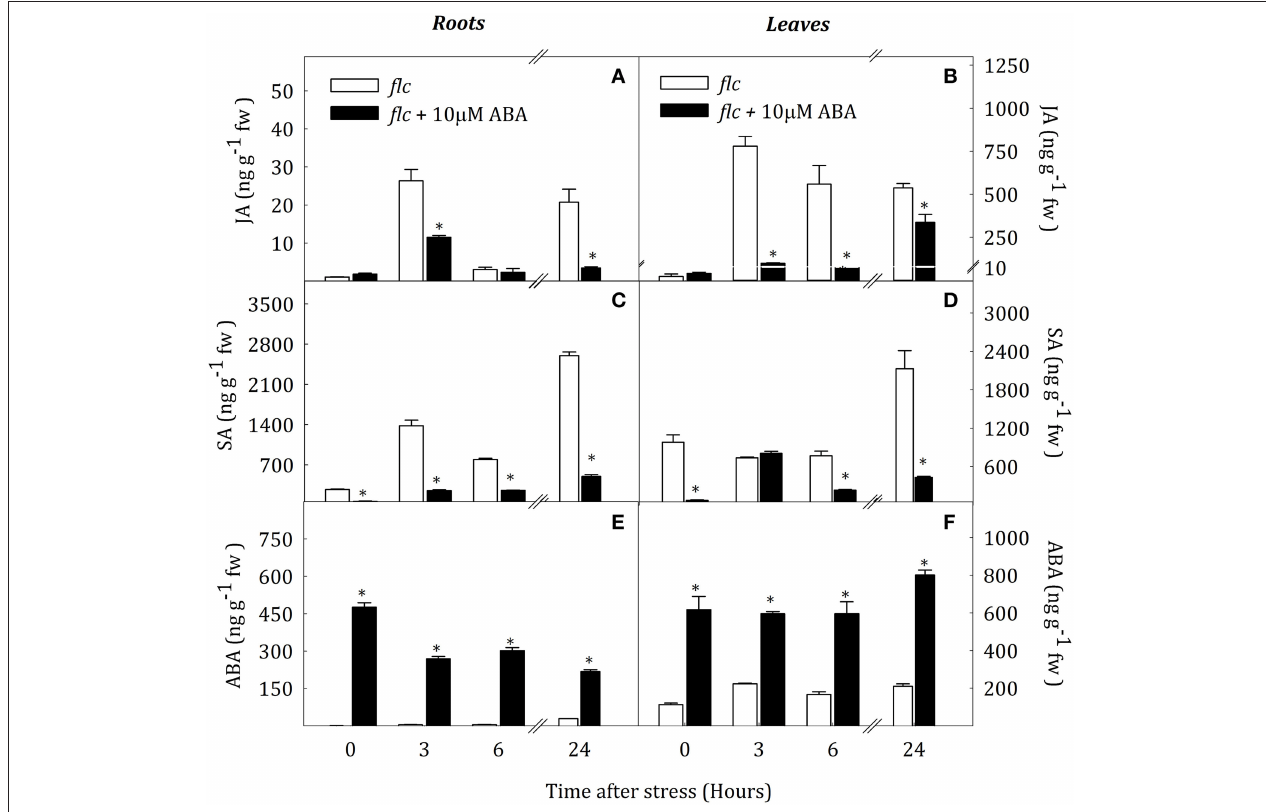
FIGURE 9 | JA (A,B), ABA (C,D) and SA (E,F) endogenous concentrations in leaves and roots of Solanum lycopersicum under control ( t = 0 ) and water-stress conditions in flc seedlings without treatment (white bars) and flc seedlings and previously treated with 10 µ M ABA (black bars). Data are mean values ± standard deviation of three independent determinations. Asterisks denote statistical difference with respect to WT at p ≤ 0.05